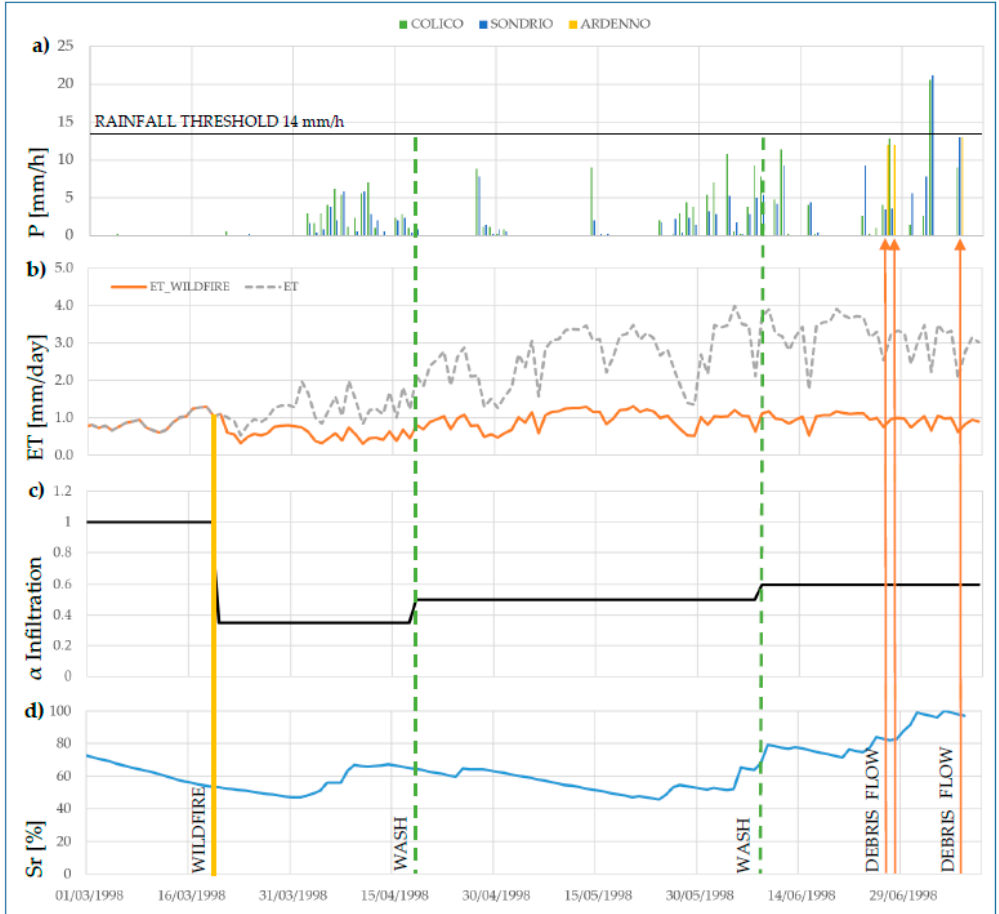
Figure 5. For the Ardenno Area : ( a ) Rainfall series recorded; ( b ) wildfire effects on Evapotranspiration; ( c ) Wildfire effects on Infiltration coefficient, α ; ( d ) model simulation of the terrain’s degree of saturation. The vertical lines report the Wildfire event, while the Wash events represent the infiltration recovery and Debris flow events.